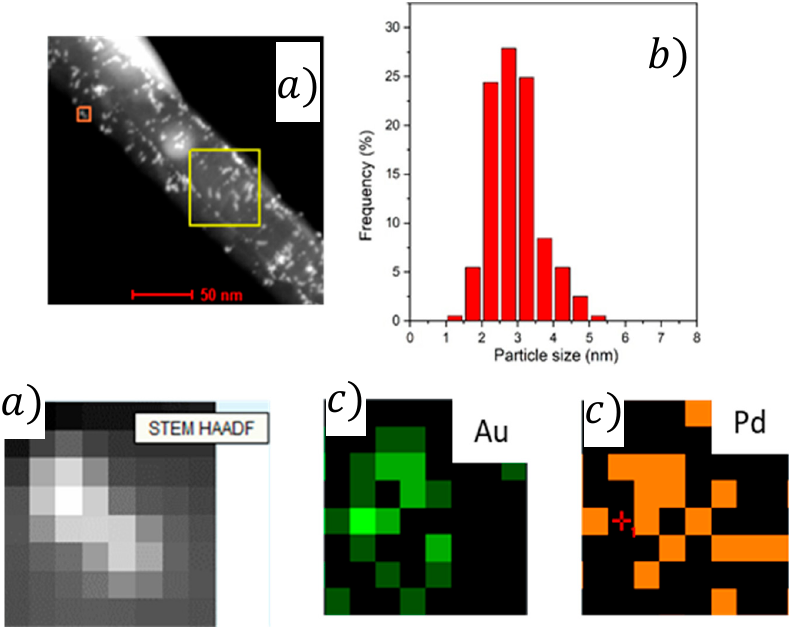
Figure 2. TEM, NP size distribution, and EDX analysis of Pd 6 Au 4 catalyst. Figure 2. ( a ) TEM, ( b ) NP size distribution, and ( c ) EDX analysis of Pd 6 Au 4